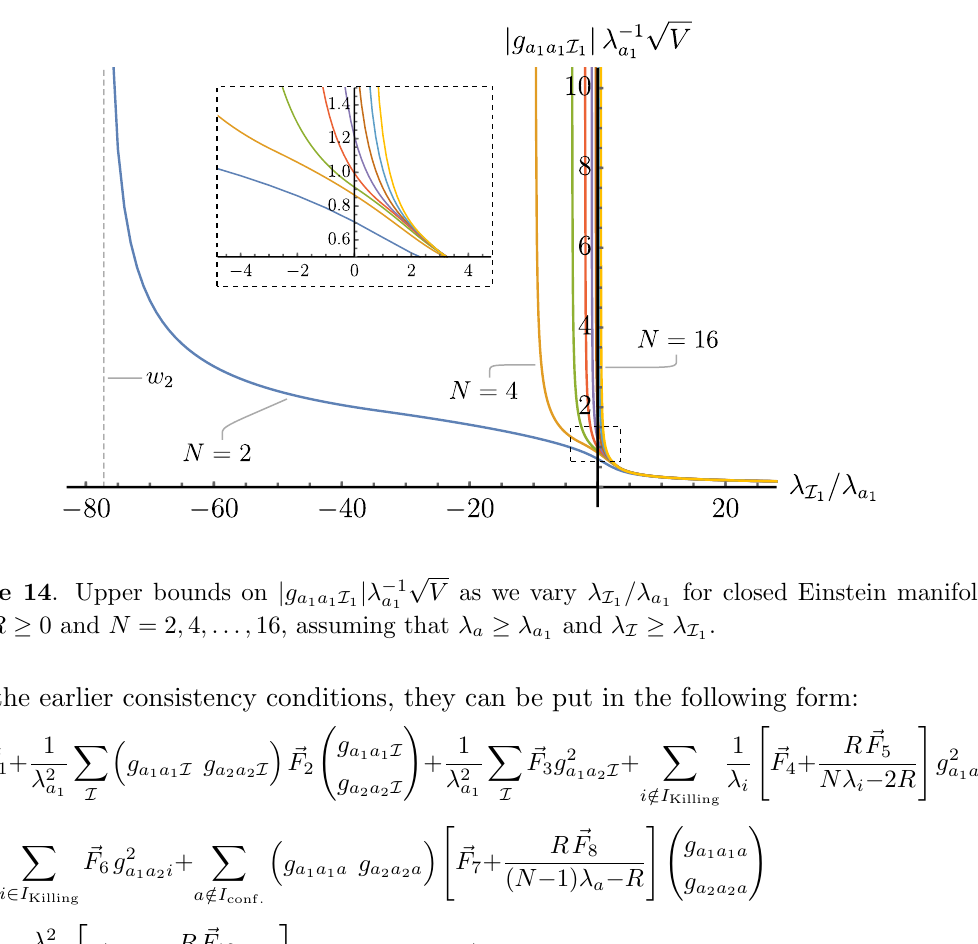
Figure 13 . Upper bounds on j g a with R (cid:21) 0, N = 2 ; 4 ; : : : ; 20, and a lightest Lichnerowicz eigentensor with (cid:21) I f (cid:21) a g [ [ (cid:21) a ; 1 ). The crosses at (cid:21) a 1 2